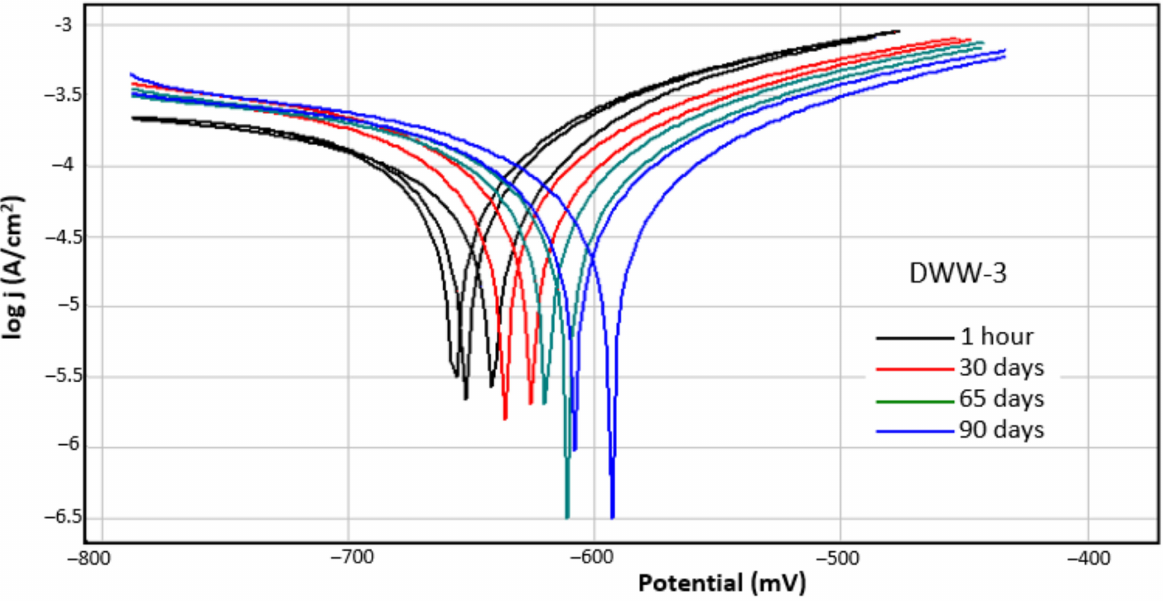
Figure 3. Polarisation curves for nodular cast-iron immersed in various time intervals in